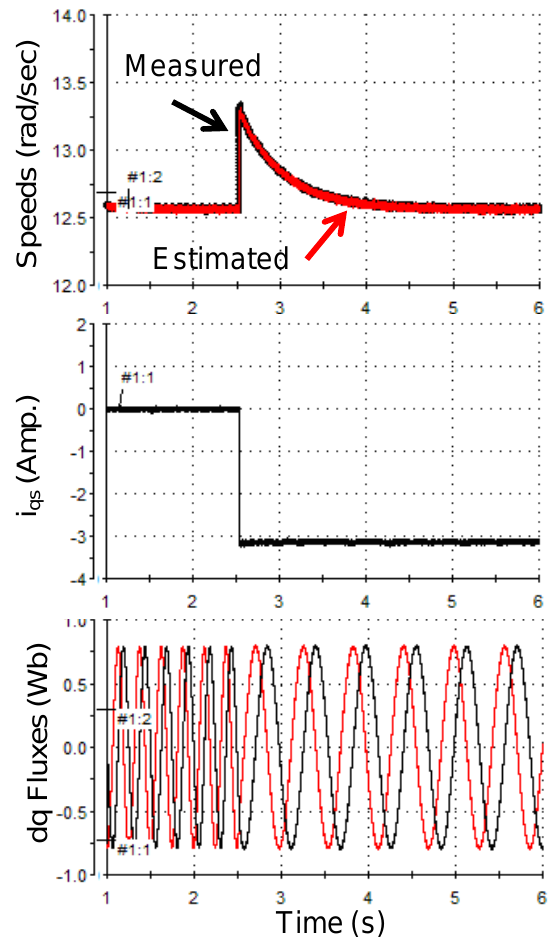
Figure 14. Practical tests of at a speed reference of 0.08 p.u (12.56 rad/s) with rated T L change of − 7 N.m at t = 2 s.